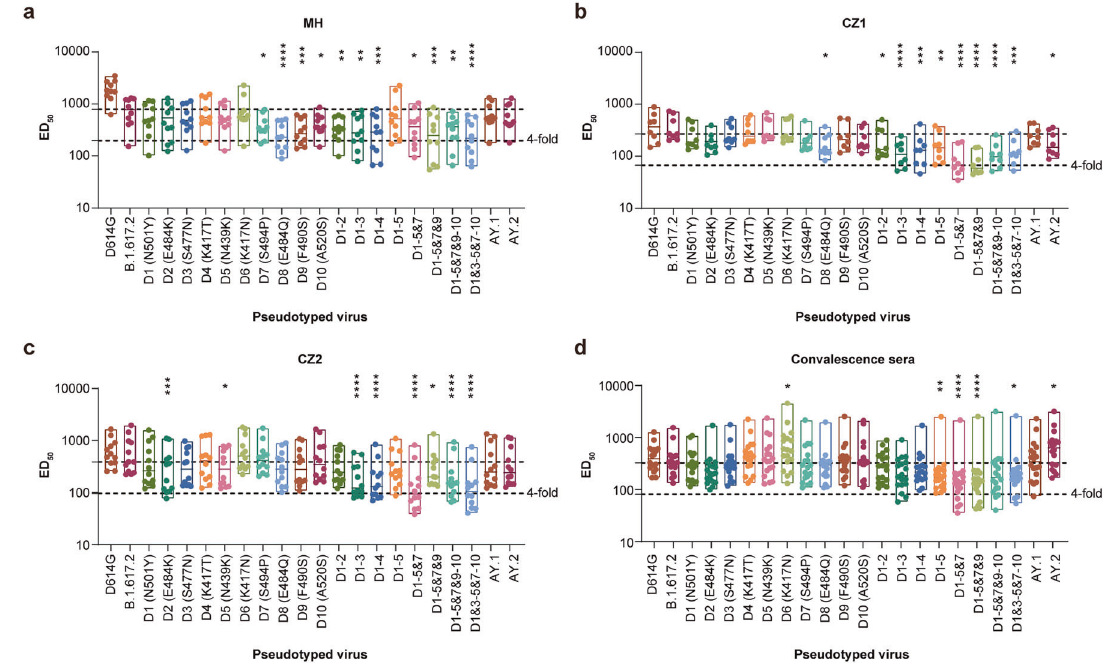
Fig. 4 Neutralization activity of convalescent and vaccine-elicited sera against possible Delta variants with multiple amino acid changes in RBD. The neutralization activity of convalescent serum ( a ), recombinant S protein vaccine-immunized sera ( b and c ), and inactive vaccine- immunized sera ( d ) against different potential SARS-CoV-2 variants were tested. Mean ED 50 from three repeated experiments are shown as dot plots. The dashed lines represent the geometric mean and fourfold reduction for serum response of the reference Delta variant, respectively. RBD receptor binding domain, SARS-CoV-2 severe acute respiratory syndrome coronavirus 2, ED 50 50% effective